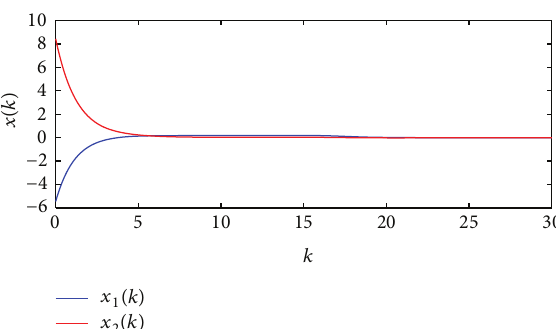
Figure 1: The Simulation solution of the states 𝑥 1 (𝑘) and 𝑥 2 (𝑘) in Example 7 for LPD discrete-time delayed system with initial conditions 𝑥 1 (𝑘) = −5.5 and 𝑥 2 (𝑘) = 8.5 , 𝑘 = −16,. . . , −2,−1, 0 and 𝛼 1 = 1/3 , 𝛼 2 = 2/3 by using method of Runge-Kutta order 4 ( ℎ = 0.01 ) with